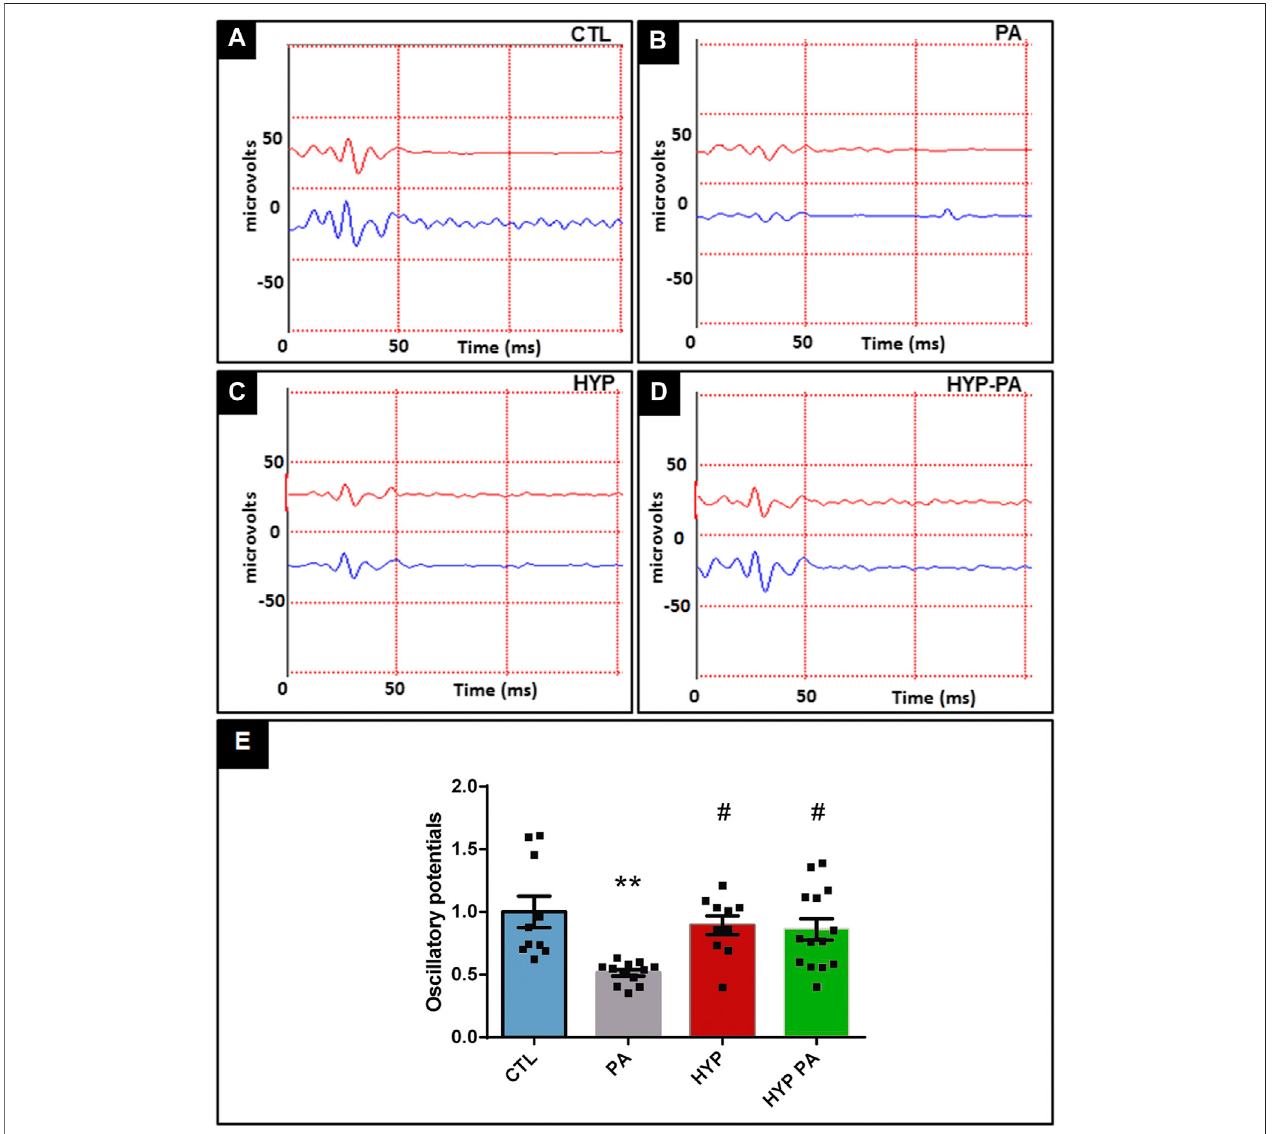
FIGURE 3 | Hypothermia prevents changes in the oscillatory potentials induced by perinatal asphyxia. Representative graphics of oscilatory potentials of 45 day- old animals (n (cid:2) 10 per group) subjected to PA in normothermic or hypothermic conditions. (A) : Control (CTL), (B) : Normothermic perinatal asphyxia (PA), (C) : Hypothermiaduringperinatalasphyxia(HYP), (D) :Hypothermic shockafterperinatalasphyxia(HYP-PA). E :Quanti fi cation oftheamplitudeoftheOP.Perinatalasphyxia (PA) induced a signi fi cant decrease in the amplitude of the OP compared to the control group (CTL), whereas both hypothermic treatments (HYP and HYP-PA) preventedit.TwowayANOVA, signi fi cantinteractionF (cid:2) 6.37, p (cid:2) 0.0012,Tukey´smultiplecomparisontest, p (cid:2) 0.0012(CTLvs.PA), p (cid:2) 0.016(PAvs.HYP), p (cid:2) 0.017 (PA vs. HYP-PA). Each bar represents the mean ± SEM of at least 10 animals. Asterisks indicate signi fi cant differences with CTL. **: p < 0.01. Pound signs indicate signi fi cant differences with PA. #: p <